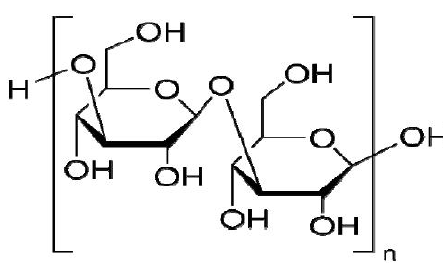
Figure 1. Structural formula of